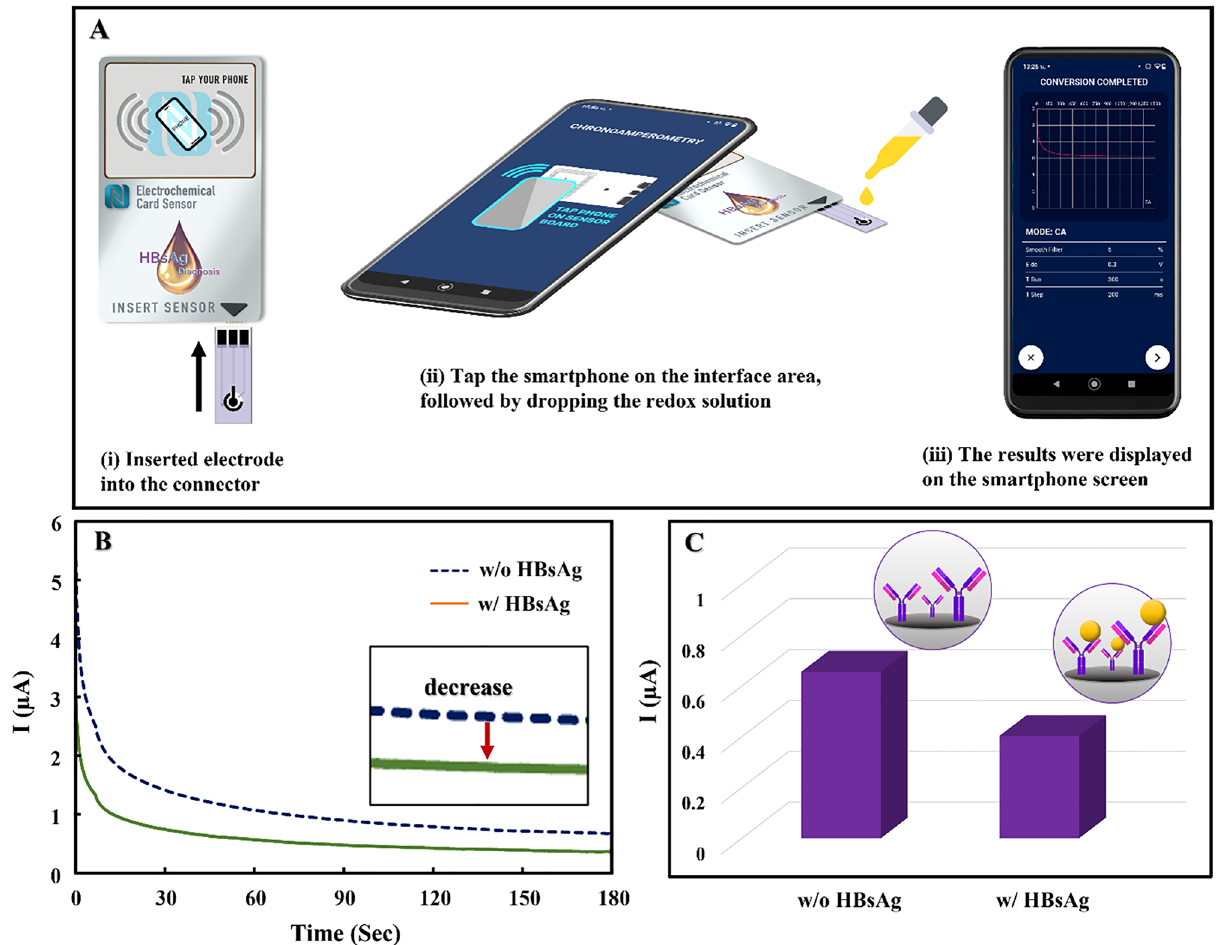
Figure 2. ( A ) The operation procedures of smartphone-based amperometric detection, ( B ) amperometric curve, and ( C ) the current response of BP/Ab/G/CHT/SPCE before and after addition of 100 IU/mL HBsAg using 2 mM [Fe(CN) 6 ] 3−/4− in 0.1 M